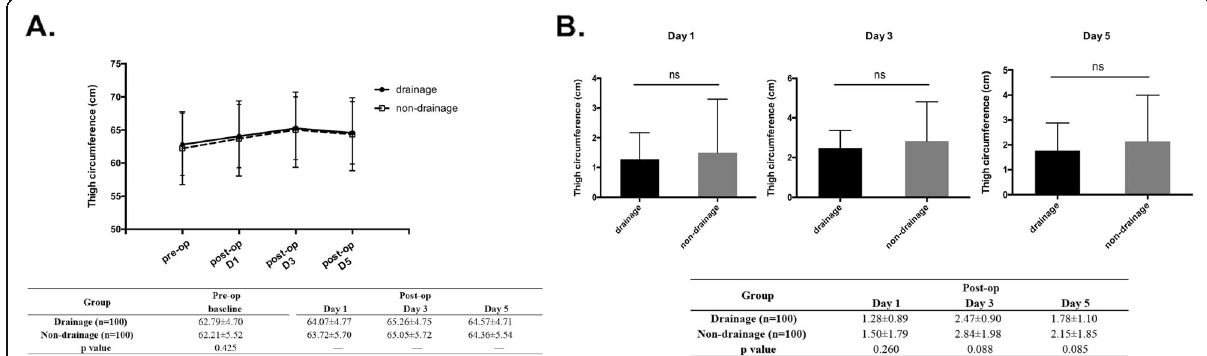
Fig. 5 Effect of drainage on thigh circumference after TKA. a . the dynamic change of thigh circumference; b . increase of the circumference at different time point compared with baseline